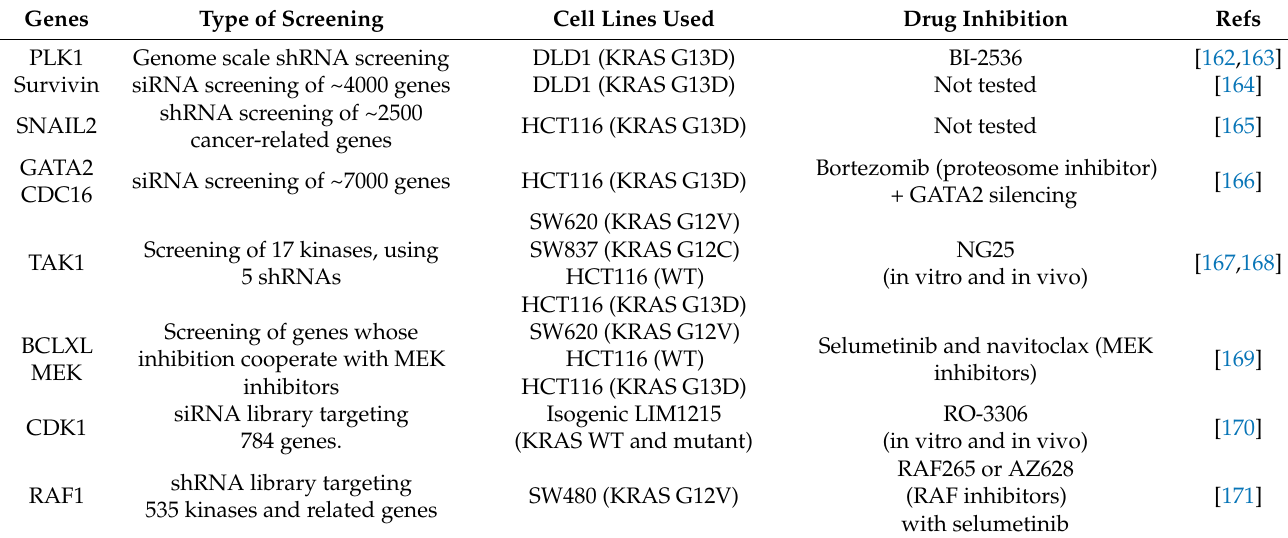
Table 3. RAS synthetic lethal genes. Screenings for searching targets for RAS synthetic lethality in CRC. Many of them were accompanied by drug-based inhibition